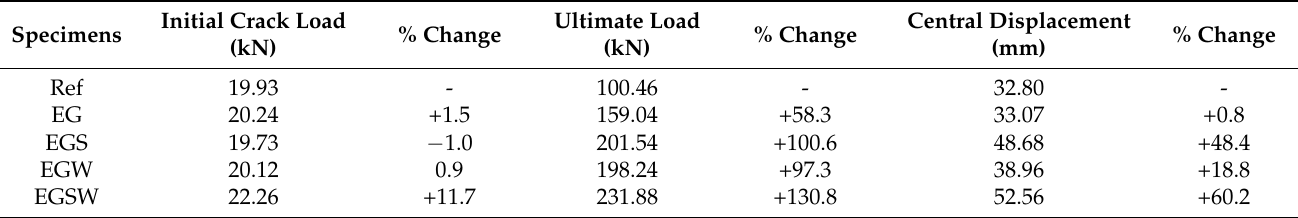
Figure 5. Load versus deflection relationships for the tested beams. Table 4. Comparisons of the initial crack load, ultimate load, and central displacement.